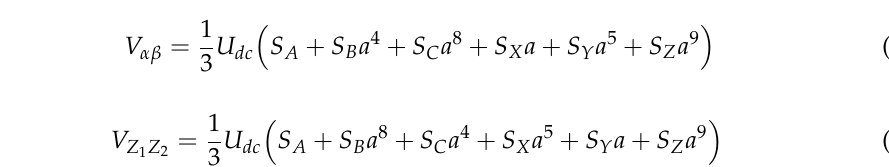
Figure 1. An asymmetric six-phase motor fed by six-phase two-level VSI. The voltage vectors corresponding to each switching state in the α − β subspace and Z 1 − Z 2 subspace are determined by (1) and (2), respectively.